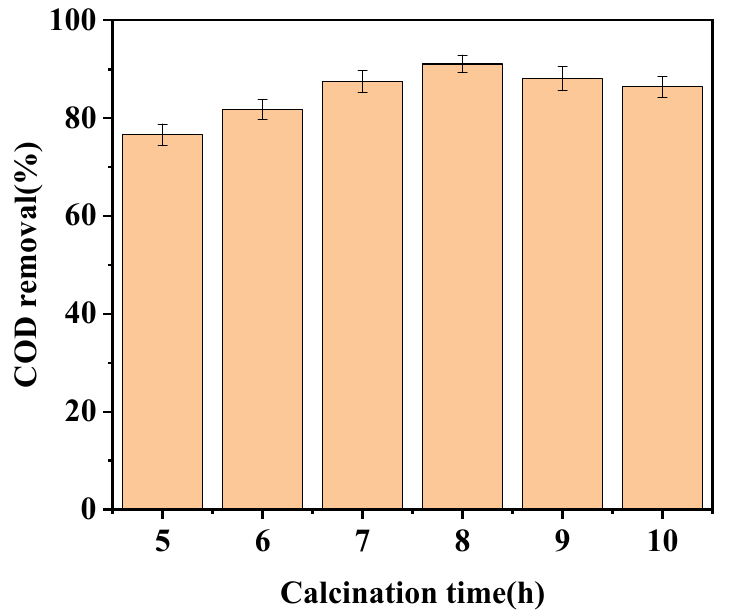
Figure 4. Effect of calcination time on catalytic effect. (Catalyst preparation conditions: catalyst support, CeO 2 , calcination temperature = 800 °C; Reaction conditions: LaCoO 3 /CeO 2 = 0.8 g/L, H 2 O 2 = 40 mM, 120 °C, 1 MPa, 60 min).